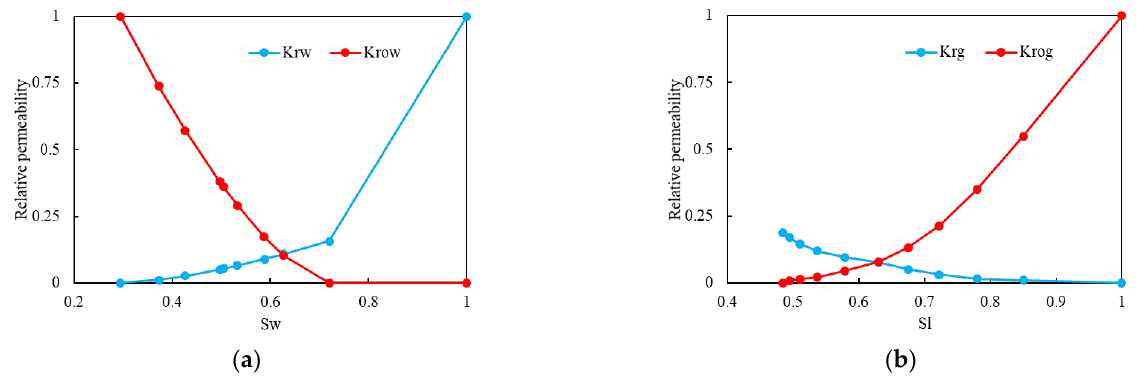
Figure 7. Relative permeability curve: ( a ) the oil – water relative permeability curve; ( b ) the gas – liquid relative permeability curve.